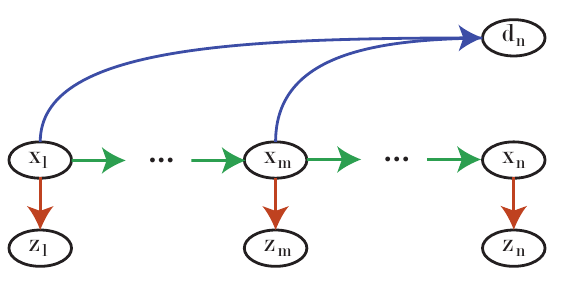
layed displacement measurement d n be- ing dependent on the states x l and x m , but arriving at t n . Green arrows repre- sent (1), red arrows represent (2), and blue arrows represent